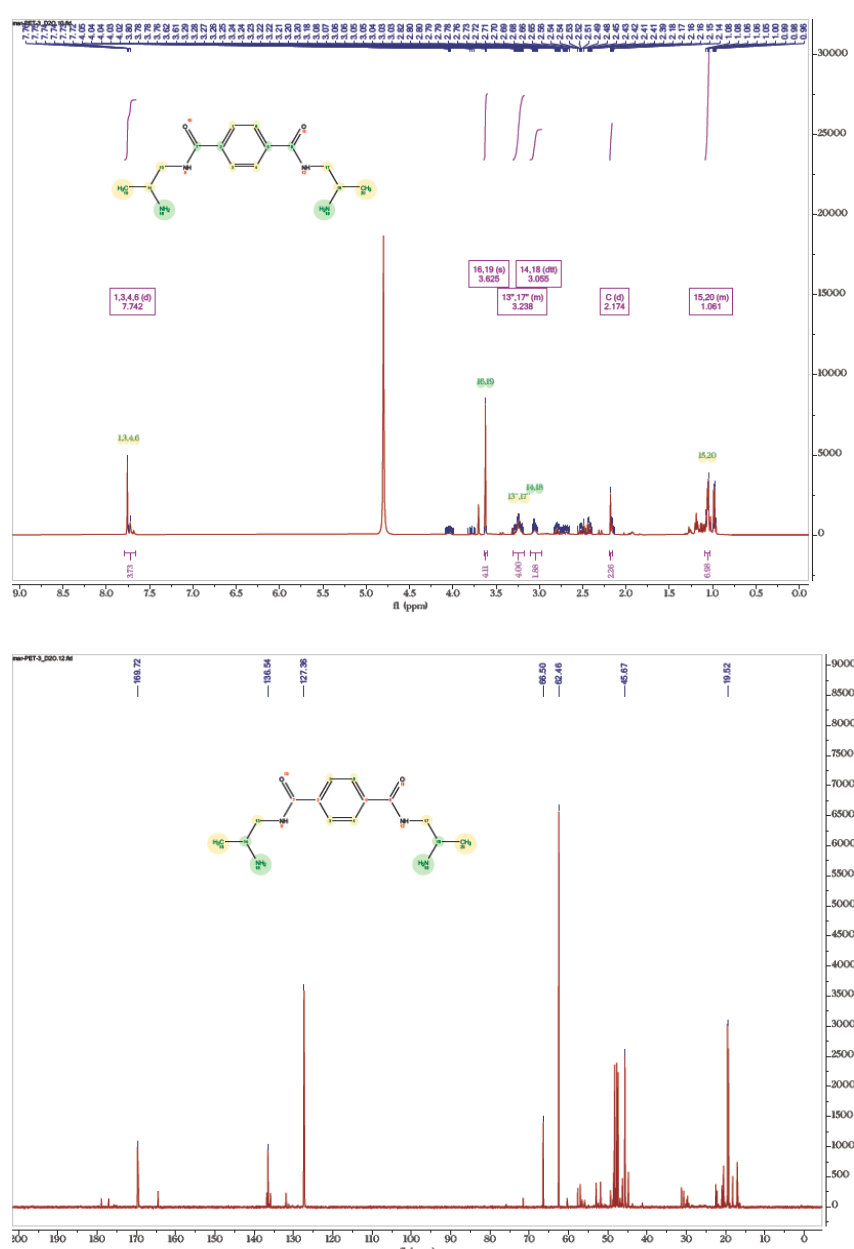
Figure 5. 1 H and 13 C NMR spectra of aminolysed product (3) obtained by method C. Table 2. Molecular formula and mass of the aminolysed products. Unit Mol. Formula Mol. Wt. (Calculated) Mol. Wt. (Observed)